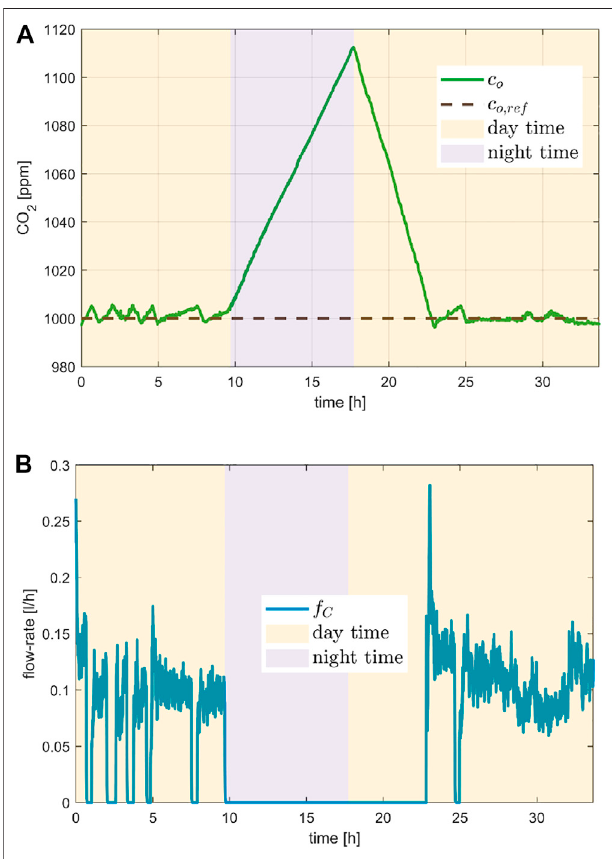
FIGURE 7 | CO 2 control performance evaluated in a day/night cycle at the second day of the experiment. Plot (A) shows the tracking of the CO 2 set- point and plot (B) the fl ow rate of the injected CO 2